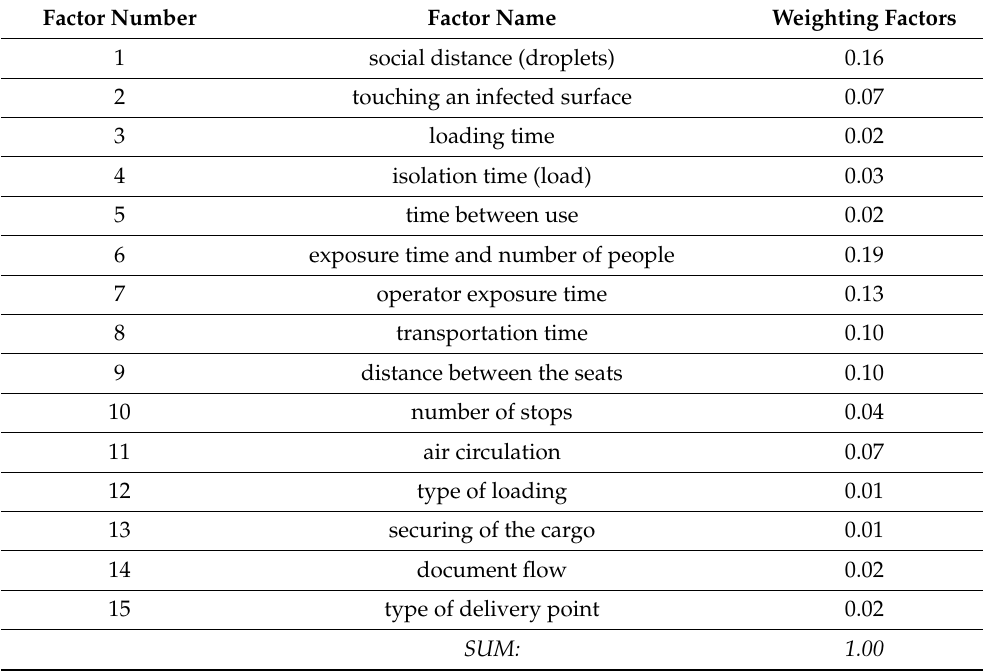
Table 3. Weighting factors for the hazard factors of the DHI methodology.